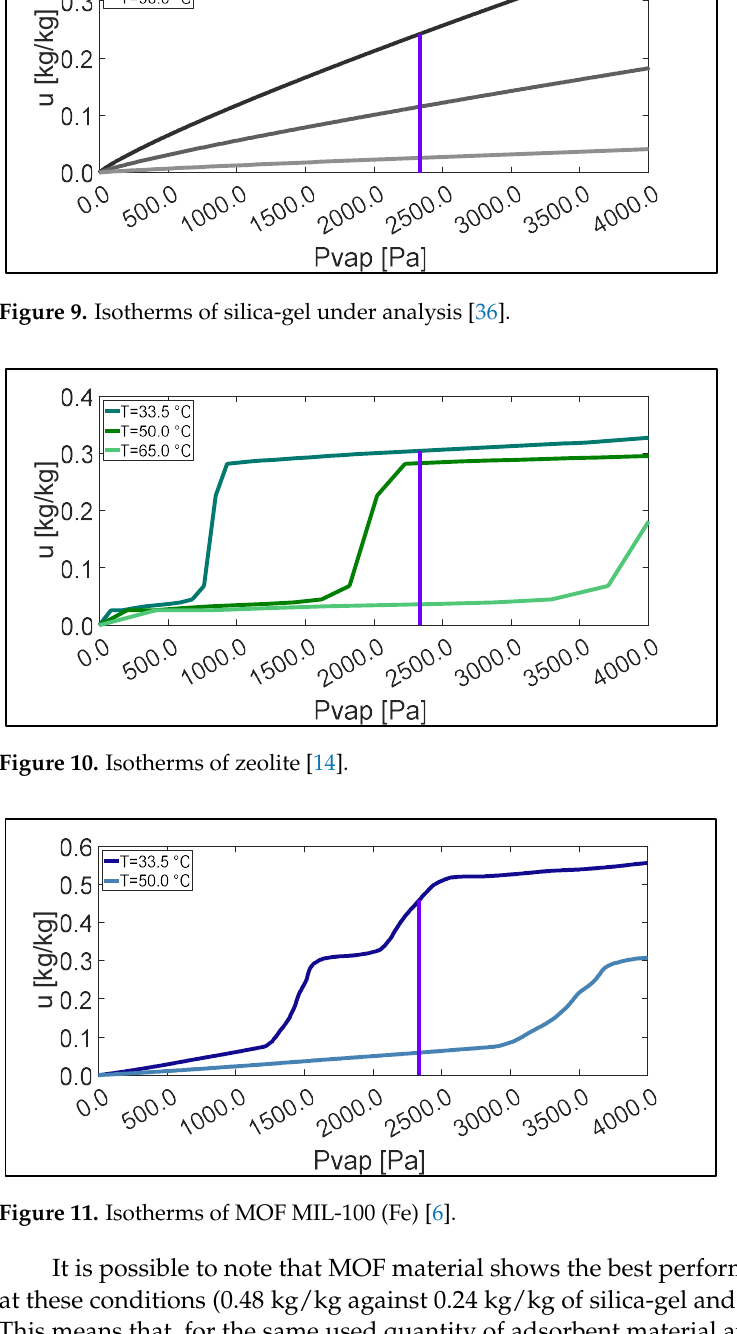
Table 5. Uptake and regeneration characteristics of the material under comparison.